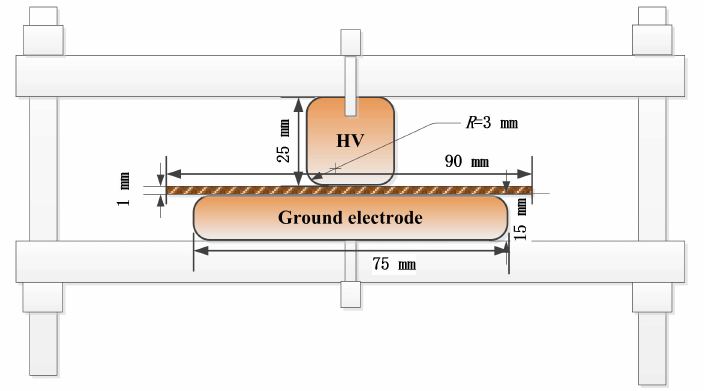
Figure 1. Cylinder-plate electrodes configuration.